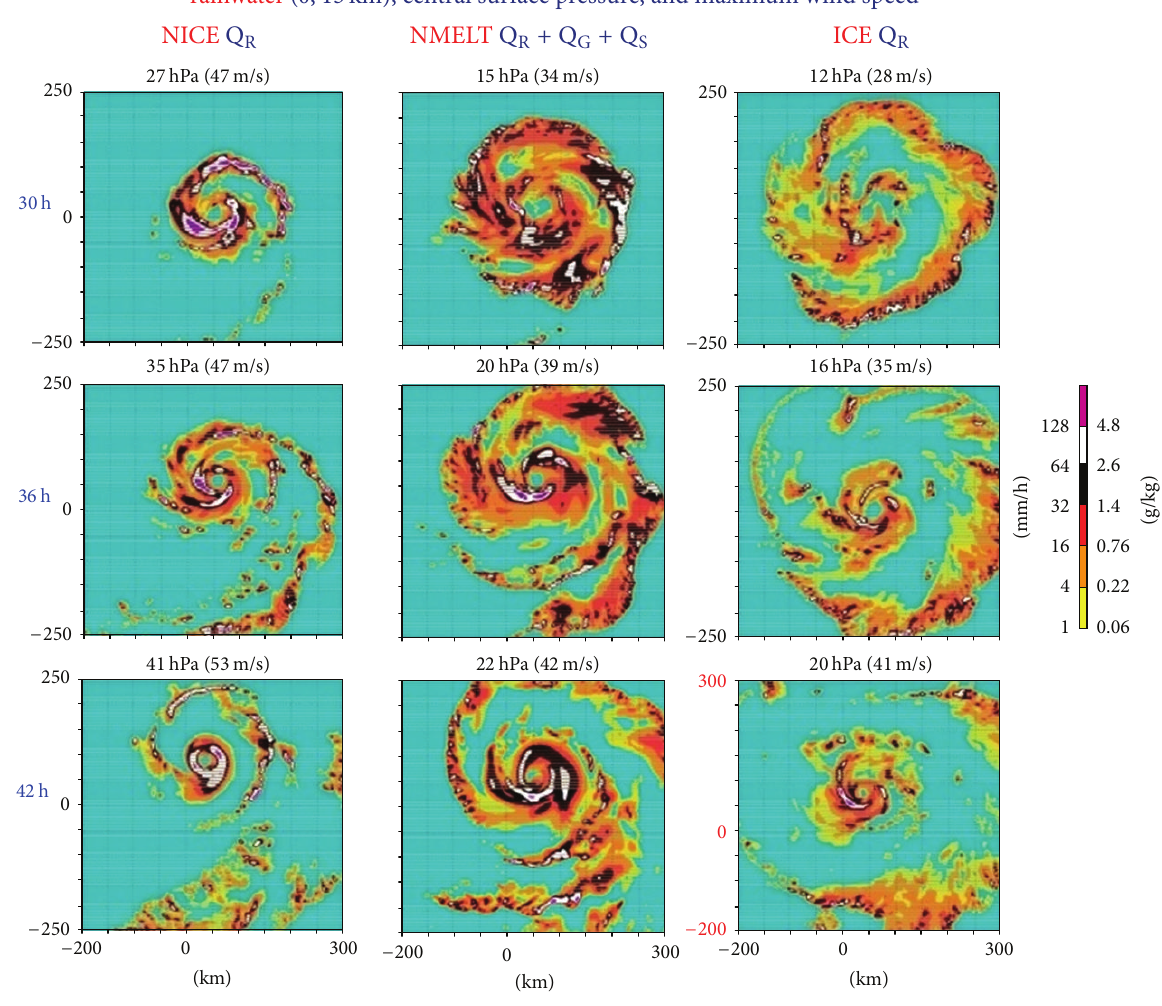
Figure 2: Same as Figure 1 but for 30 h, 36 h, and 42